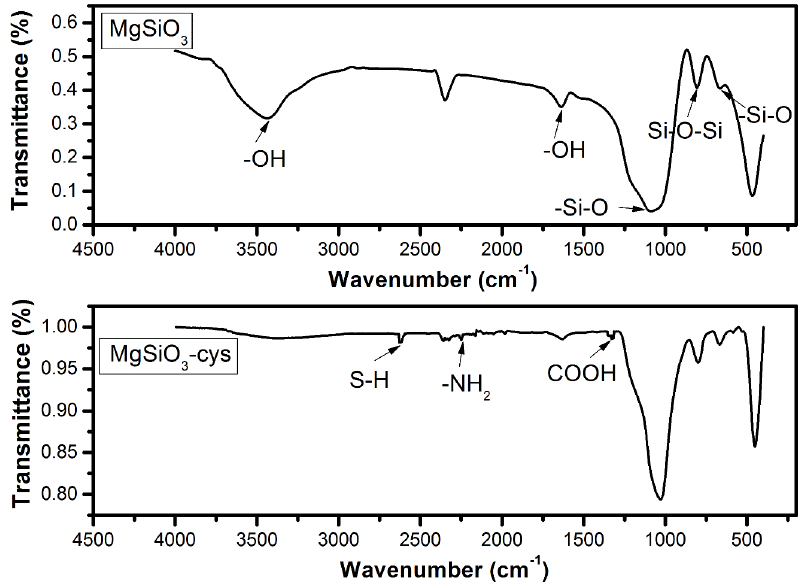
Figure 5. The FTIR spectra for commercial magnesium silicate and functionalized MgSiO 3 -cys.